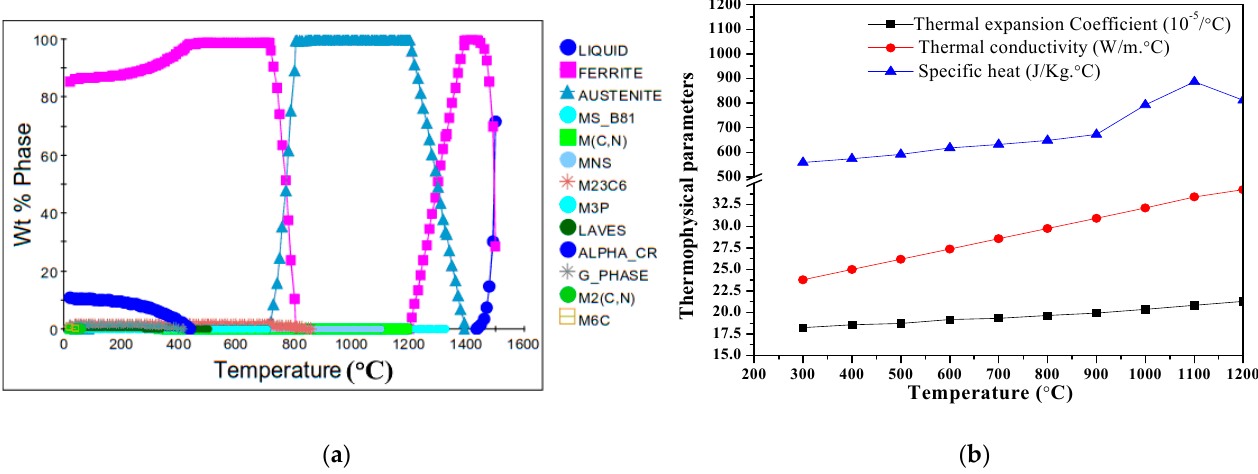
Figure 2. Solidification of X6CrNiMoVNb11-2 steel: ( a ) alloy phase diagram; ( b ) thermophysical